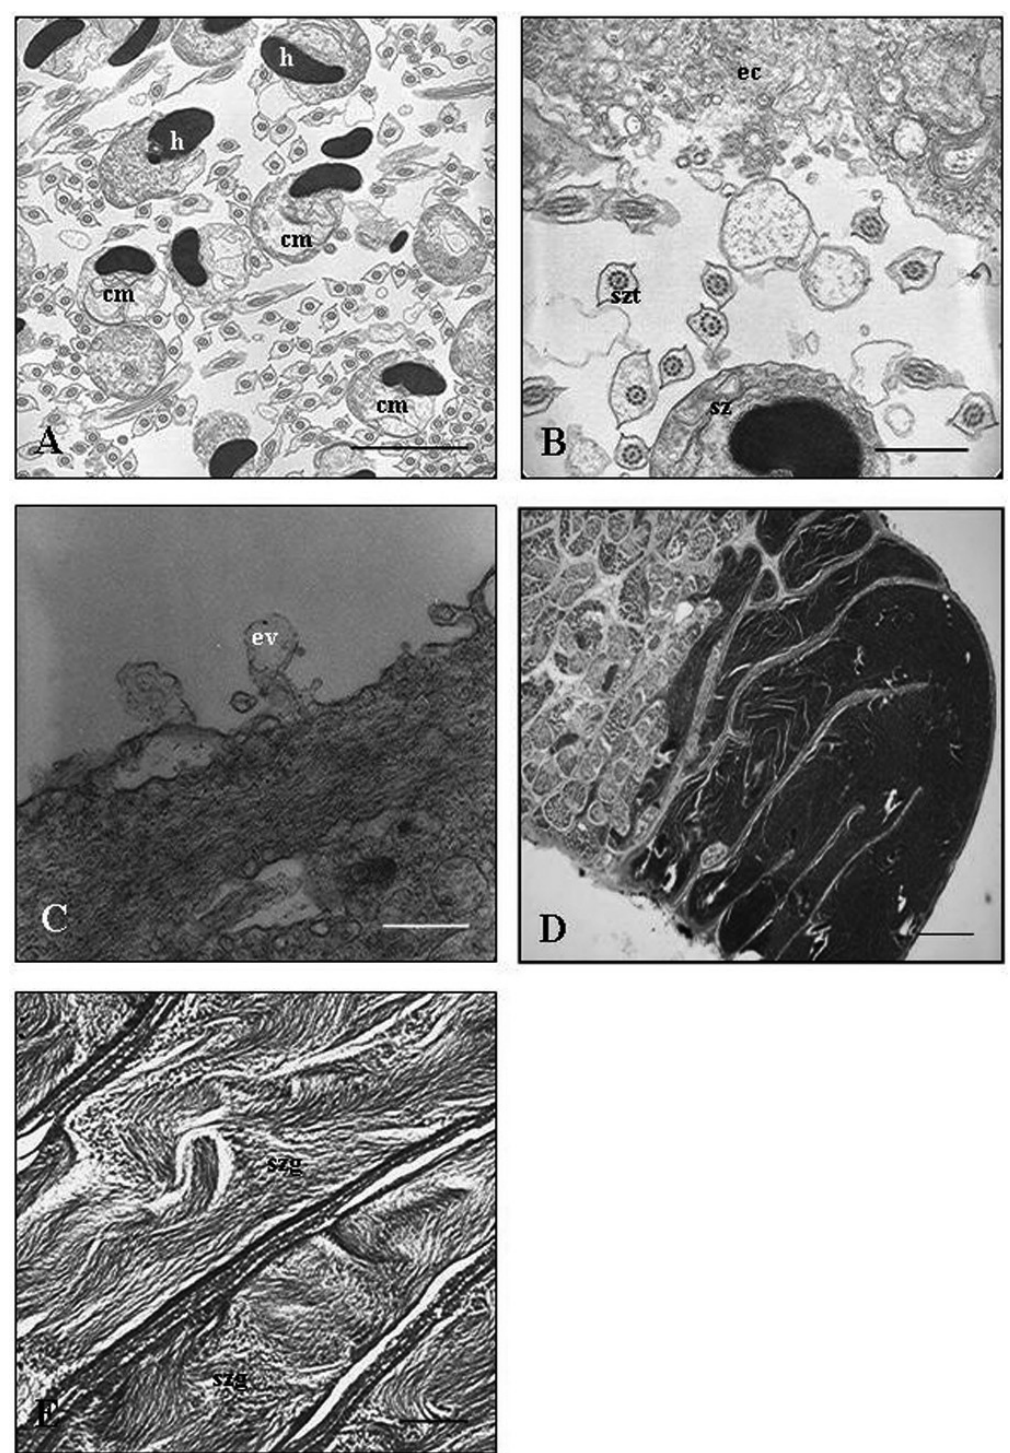
Fig . 3. – A, spermatozoa in the posterior part of the testis showing cytoplasmic masses around their heads (cm, cytoplasmic mass; h, sperm head); B, overview of the posterior part of the testis, in which epithelial cells of the sperm duct exhibit cytoplasmic projections (ec, epithelial cells; sz, spermatozoa; szt, spermatozoa’s tails); C, detail of the sperm duct epithelium releasing exocytosis vesicles (ev, exocytosis vesicles), D and E, efferent ducts during the spawning period, showing masses of sperm. Note the examples of alignment of heads with heads and tails with tails. Haematoxylin-Eosin. Mallory (szg, groups of spermatozoa). Scale bars: A, 2.5 μm; B-C, 1 μm; D, 200 μm; E, 100